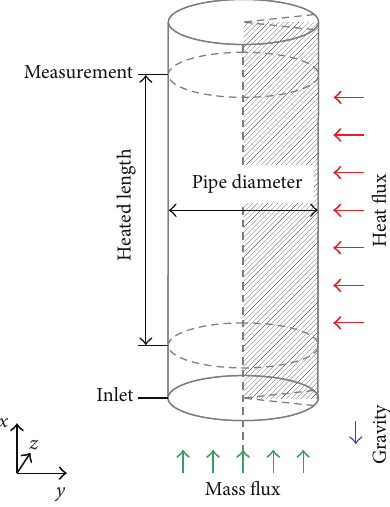
F 1: Sketch of the DEBORA test